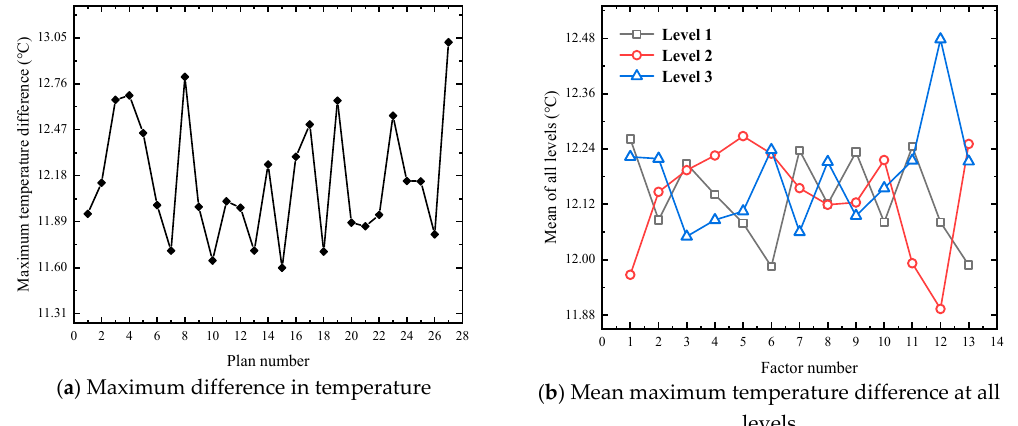
Figure 5. Variation of simulation results of minimum temperature in orthogonal experiment.